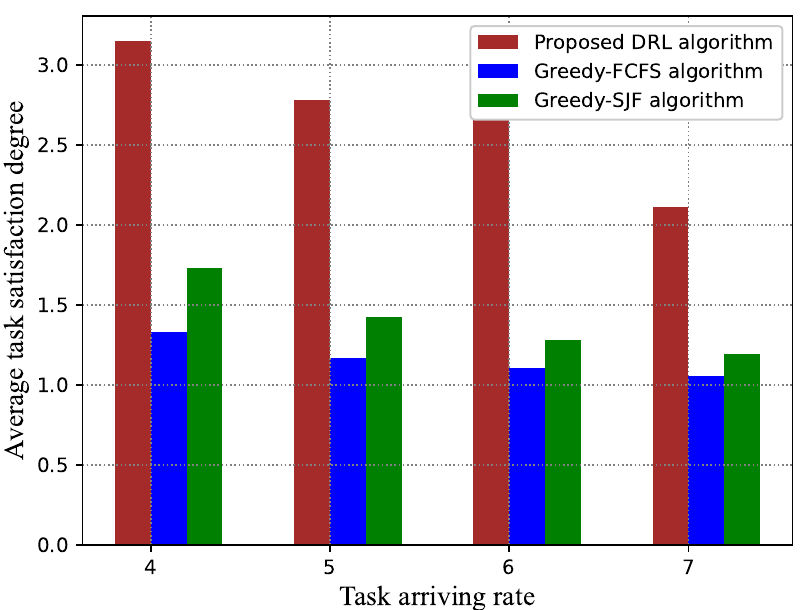
Figure 8. Average task satisfaction degree versus task arriving rate. FCFS, first-come-first-serve; SJF, shortest-job-first.